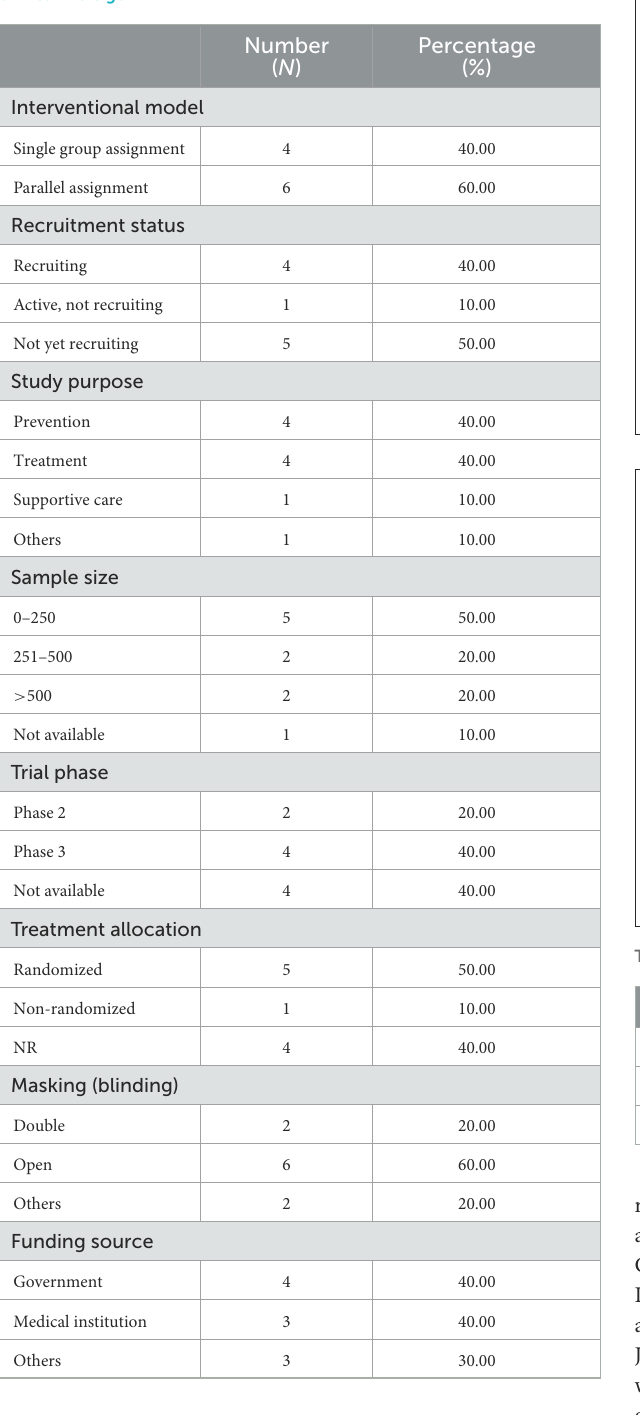
TABLE 1 Characteristics of interventional clinical trials registered on ClinicalTrials.gov.